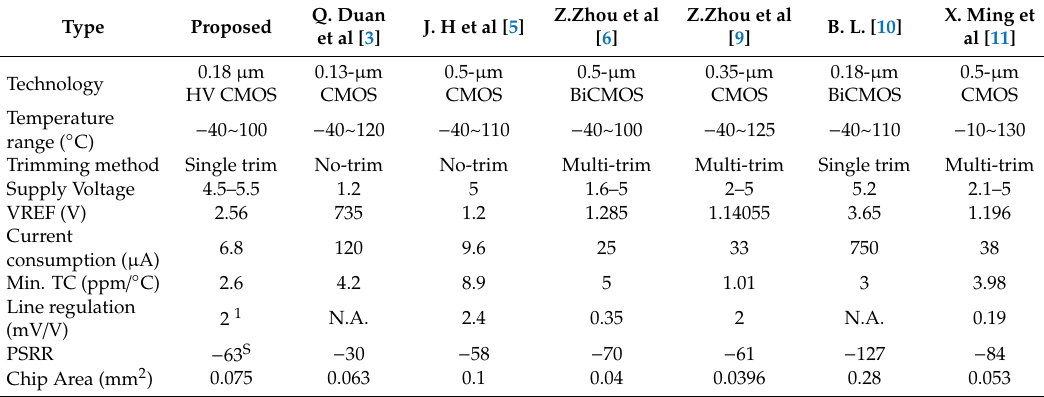
Table 2. Performance summary and comparison with other voltage